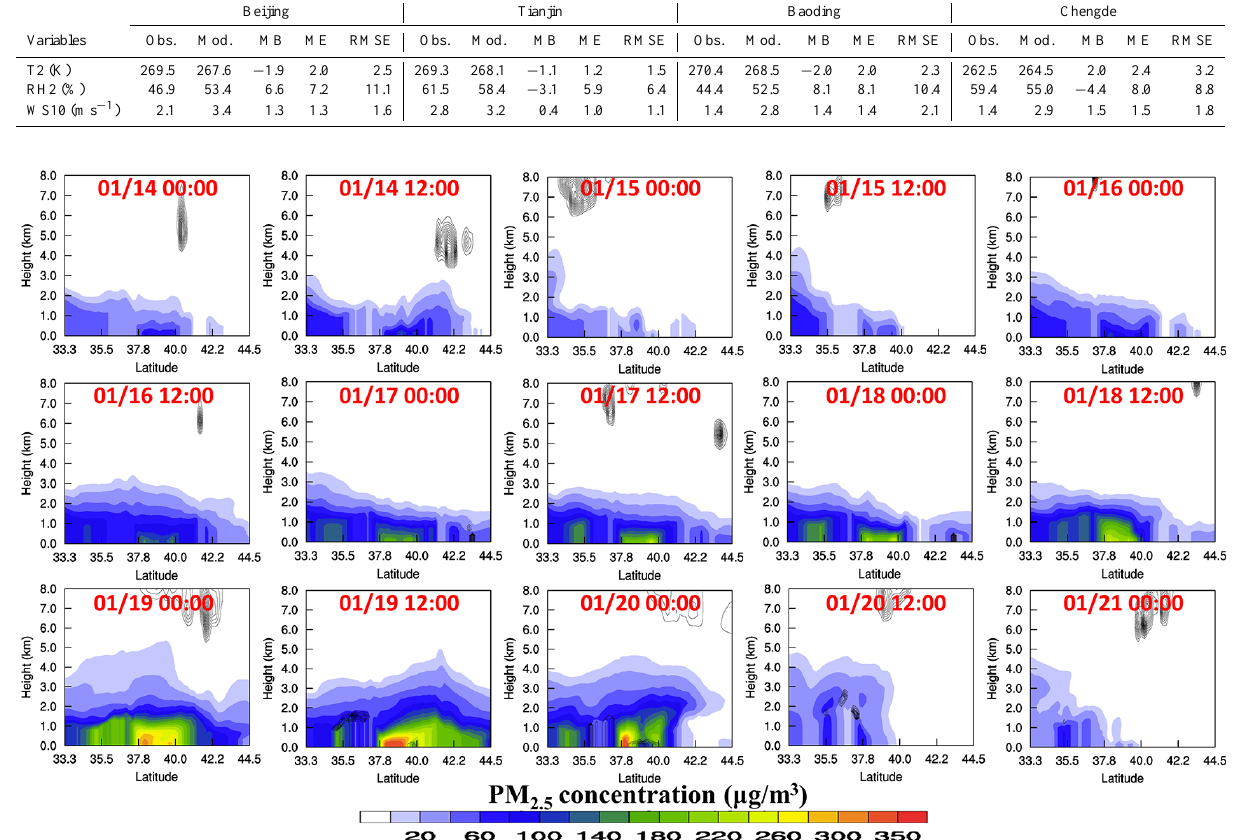
Table 2. Performance statistics for meteorological variables. Beijing